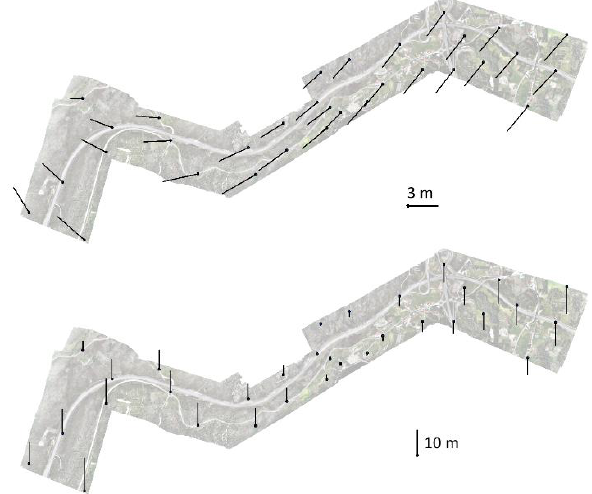
Figure 6. Graphical representation of horizontal (top) and vertical (bottom) errors of datasets OM1 and DSM1. Arrows showing reference error vectors of dimension 3 m and 10 m, have scale factors of, respectively, 100 and